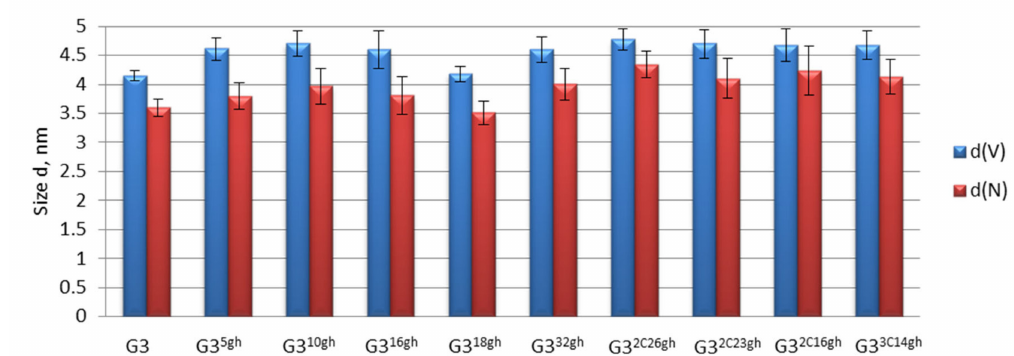
Figure 5. Size of conjugates averaged by number of molecules (d(N)) and by volume (d(V)) measured at pH 5 in 40 mM acetate bu ff er: No result for G3 9C11gh is shown at this graph. The number- and volume-averaged diameters for it are d(N) = 71 and d(V) = 81 nm, respectively.